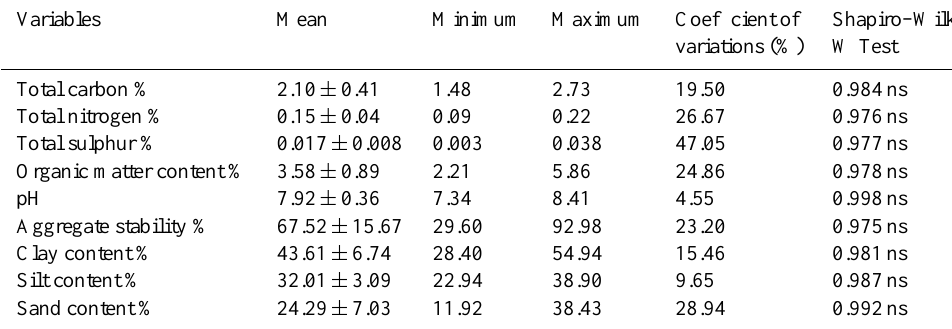
Table 2. Summary of ANOVA for soil properties. Soil properties